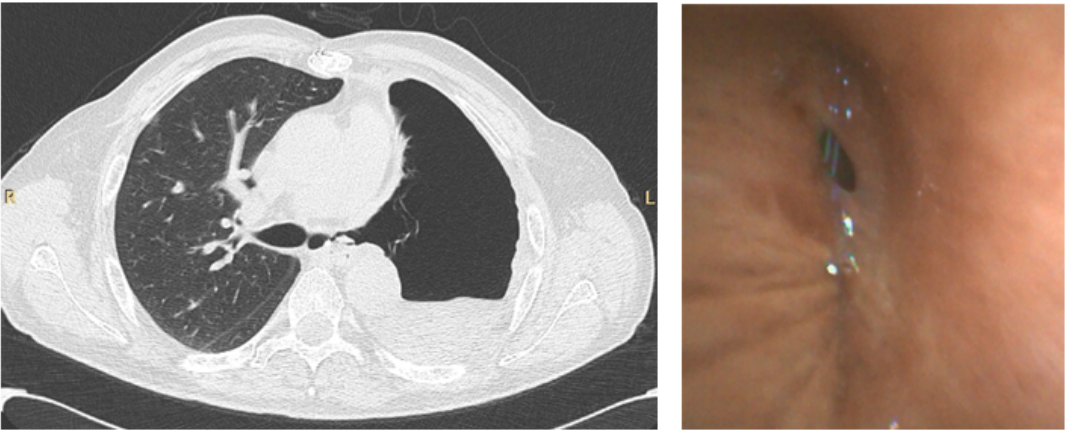
Figure 3. CT scan ( left ) of a patient that underwent left pneumonectomy, showing a possible left bronchopleural fistula, in a COVID ‐ 19 positive patient, confirmed by bronchoscopy ( right ) using single ‐ use flexible bronchoscope.